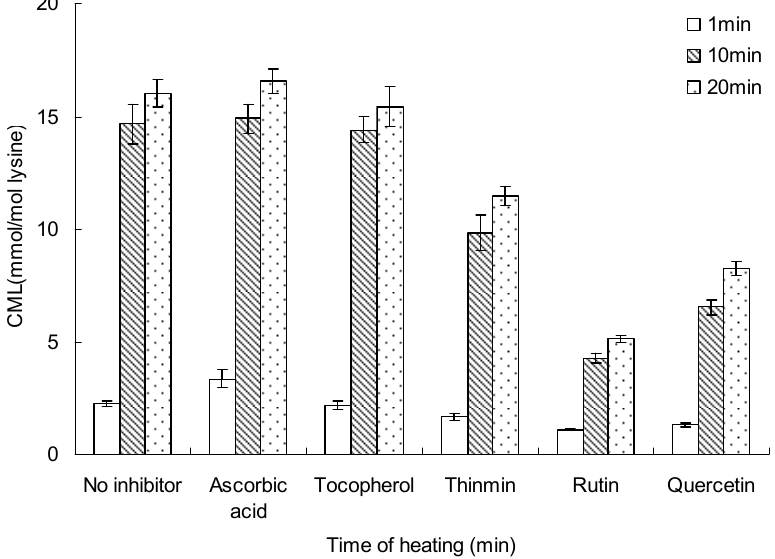
Figure 7. Inhibition time on inhibiting the formation of CML in glucose-lysine model systems during microwave heating. The heating time was 140 °C and the concentration of inhibition was 10 mM. Data points are the mean of triplicate measurements ±